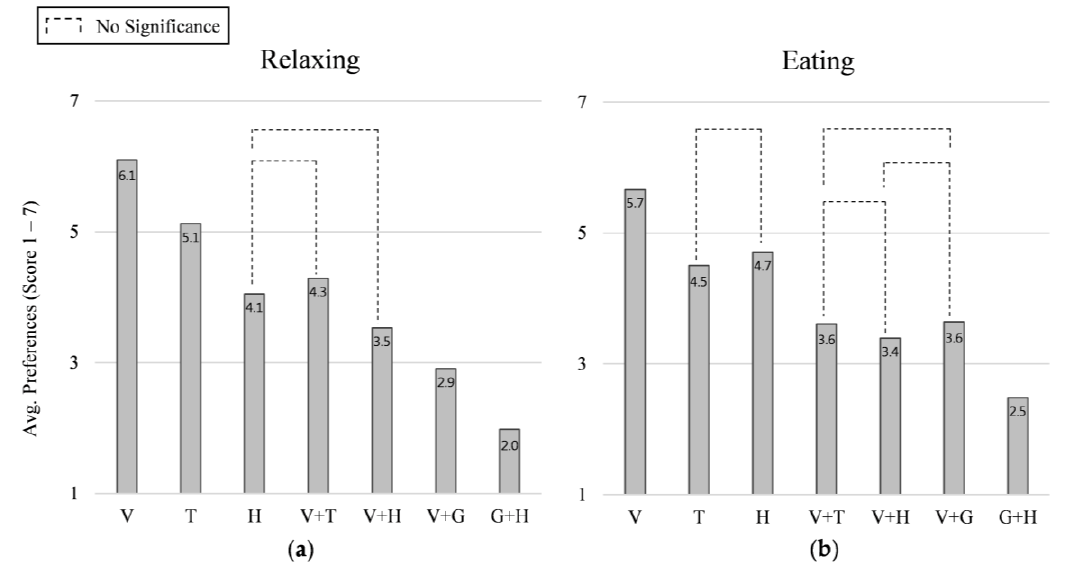
Figure 7. Preference scores for the seven input interactions in the four NDRTs: ( a ) relaxing, ( b ) eating, ( c ) working on laptop, and ( d ) watching video. 3.2.2. Input Interaction Preference Rate across NDRTs In order to understand how preference of the input interaction is influenced by NDRT, we assessed the average ranking of each input interaction in the four conditions of NDRTs. With the exception of voice + hand gesture, the preference of all input inter- actions has been highly influenced by the NDRT. A Kruskal–Wallis H test for the average ranked data in each NDRT shows signifi- cant differences between NDRTs in these input interactions: voice ( H (3) = 36.319, p = 0.000), touch ( H (3) = 49.221, p = 0.000), hand gesture ( H (3) = 48.922, p = 0.000), voice + touch ( H (3) = 57.810, p = 0.000), voice + gaze ( H ( 3) = 73.394, p = 0.000), gaze + hand gesture ( H (3) = 24.614, p = 0.000), where there was no significant differences shown in voice + hand gesture ( H (3) = 6.354, p = 0.096), as illustrated in Figure 8.